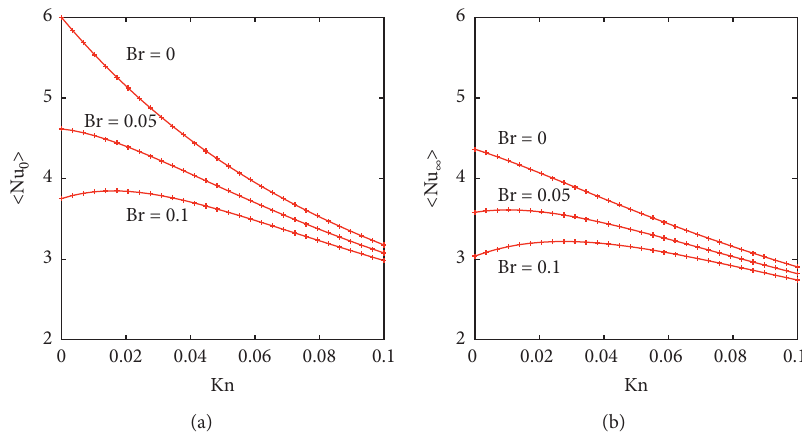
〉 for 〈 Nu 〉 as a function of Kn for Br � 0 , 0 . 05 , 0 . 1. Constant wall heat flux ∞